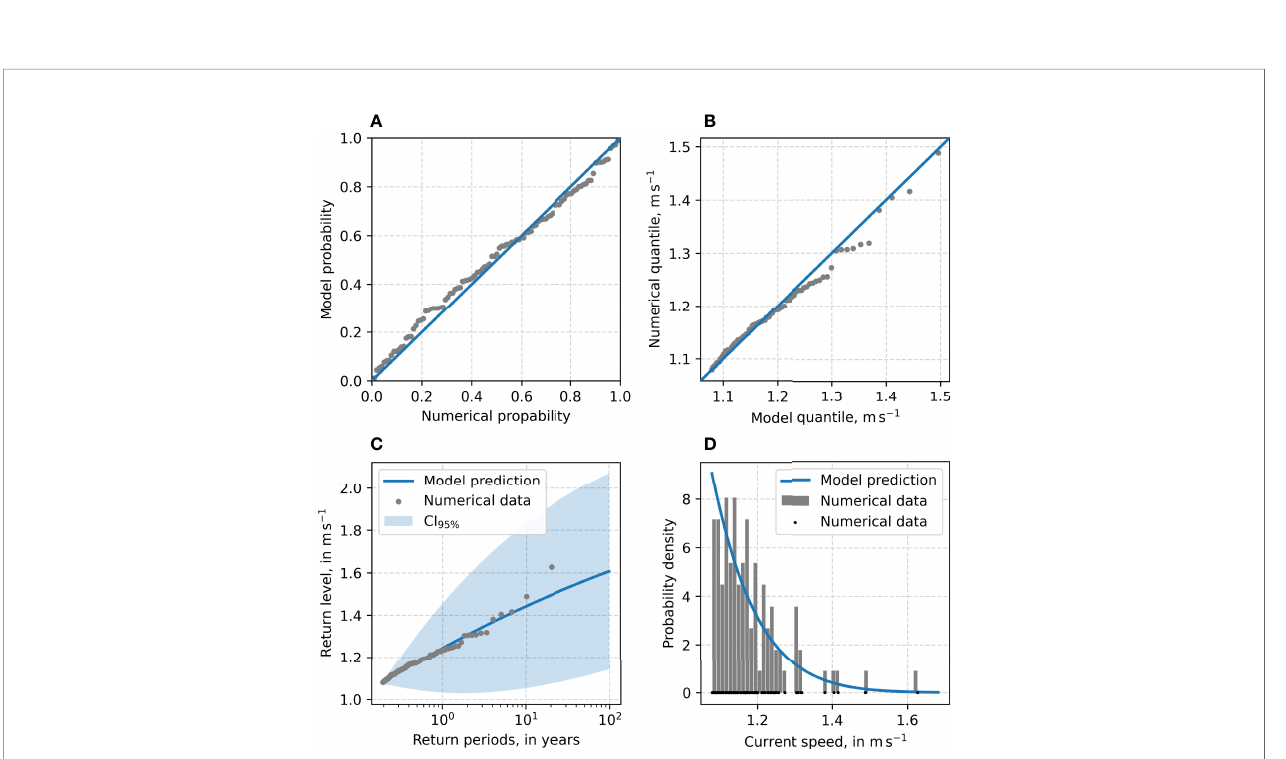
FIGURE 13 | Diagnostic plot for the GPD excess model fi tted to 3-hourly current for the node at P4. (A) p-p plot, (B) q-q plot, (C) return level plot, and (D) density